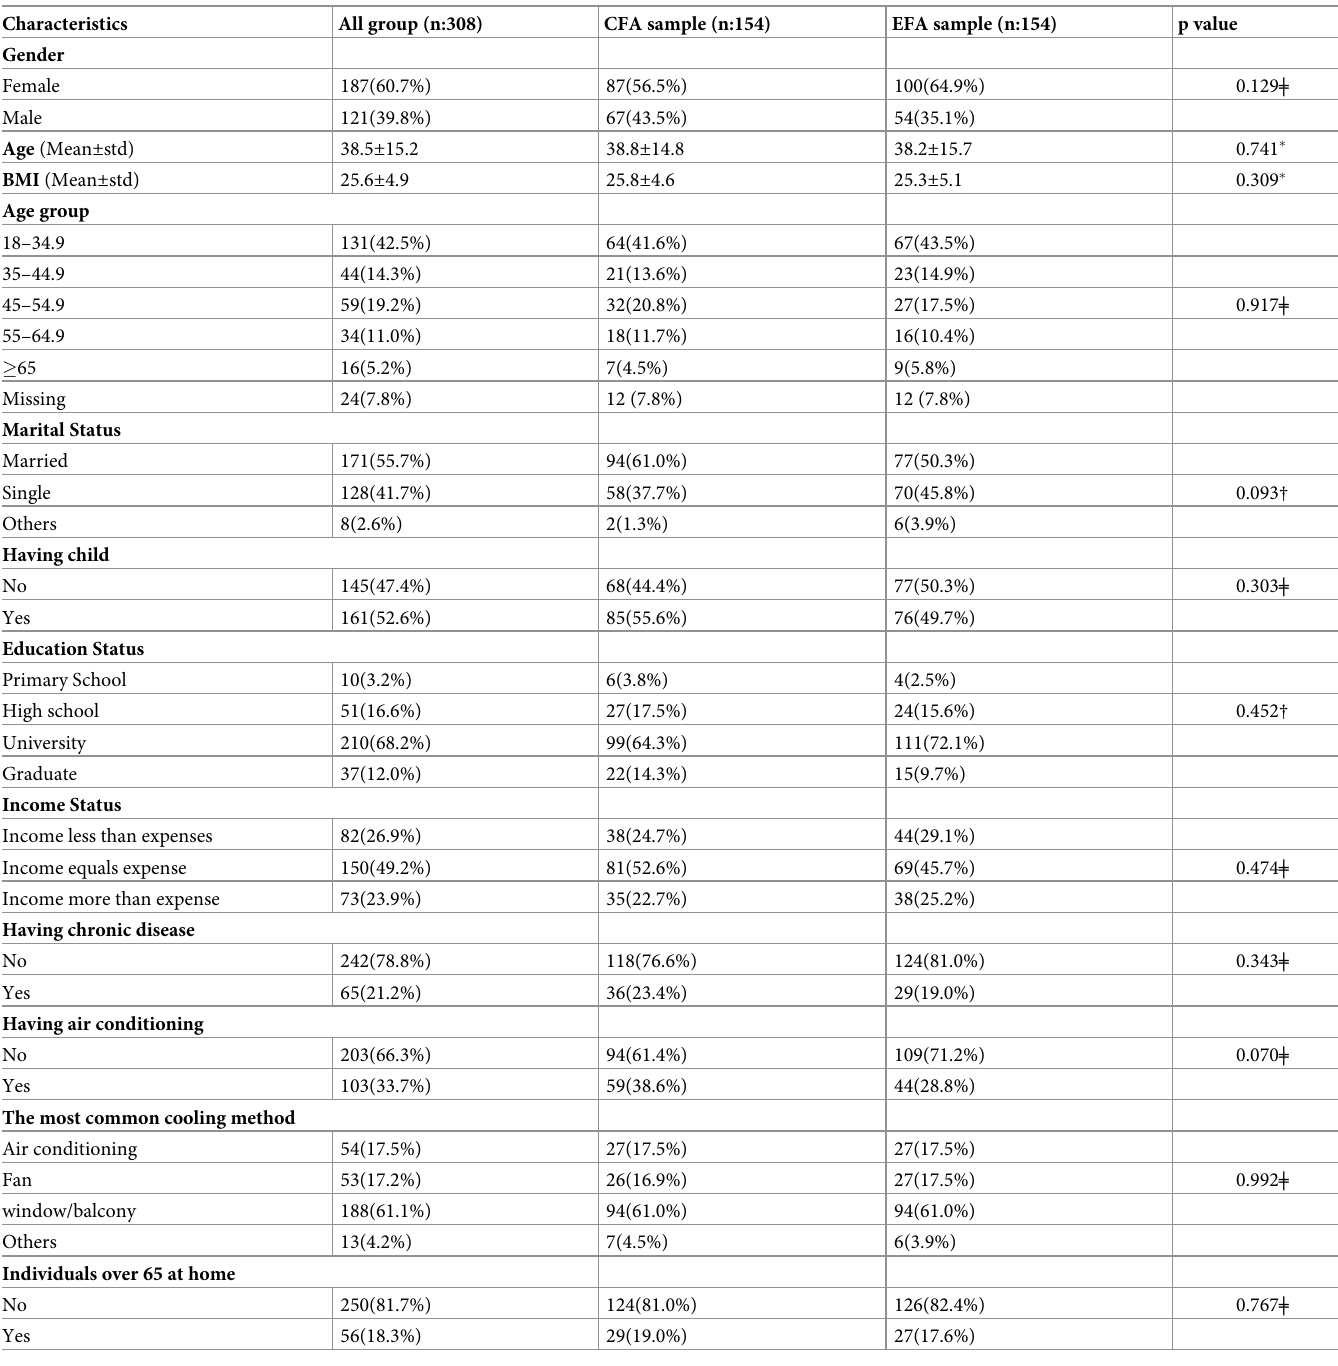
Table 1. Demographic characteristics of participants in the study (n = 308).